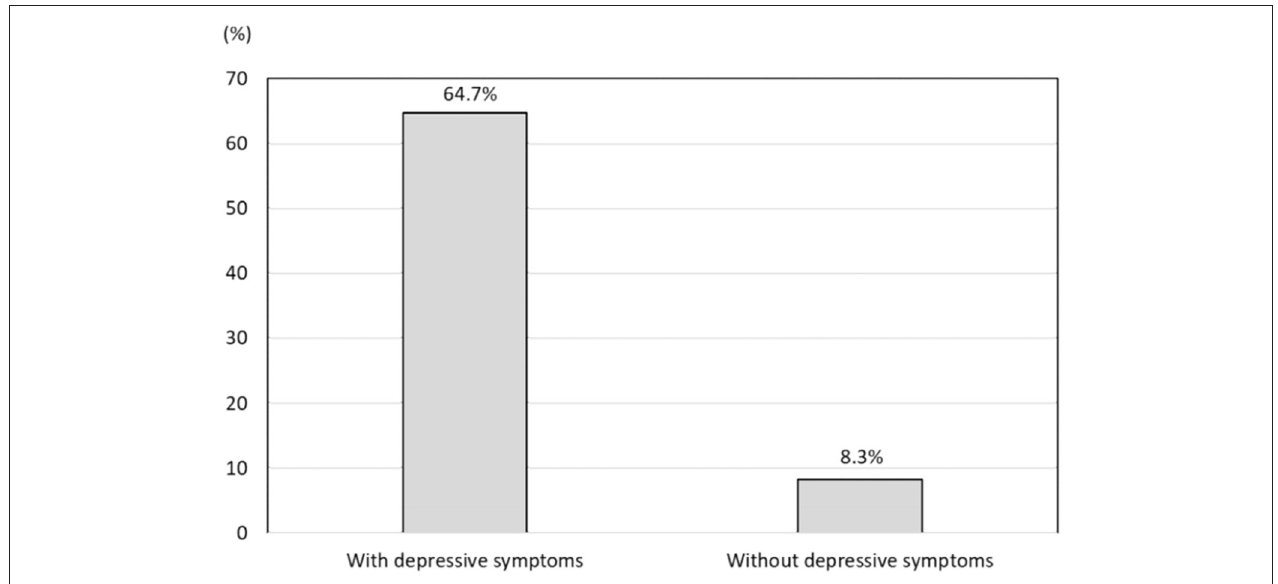
FIGURE 3 | Prevalence of insomnia symptoms in participants with depressive symptoms and those without depressive symptoms.